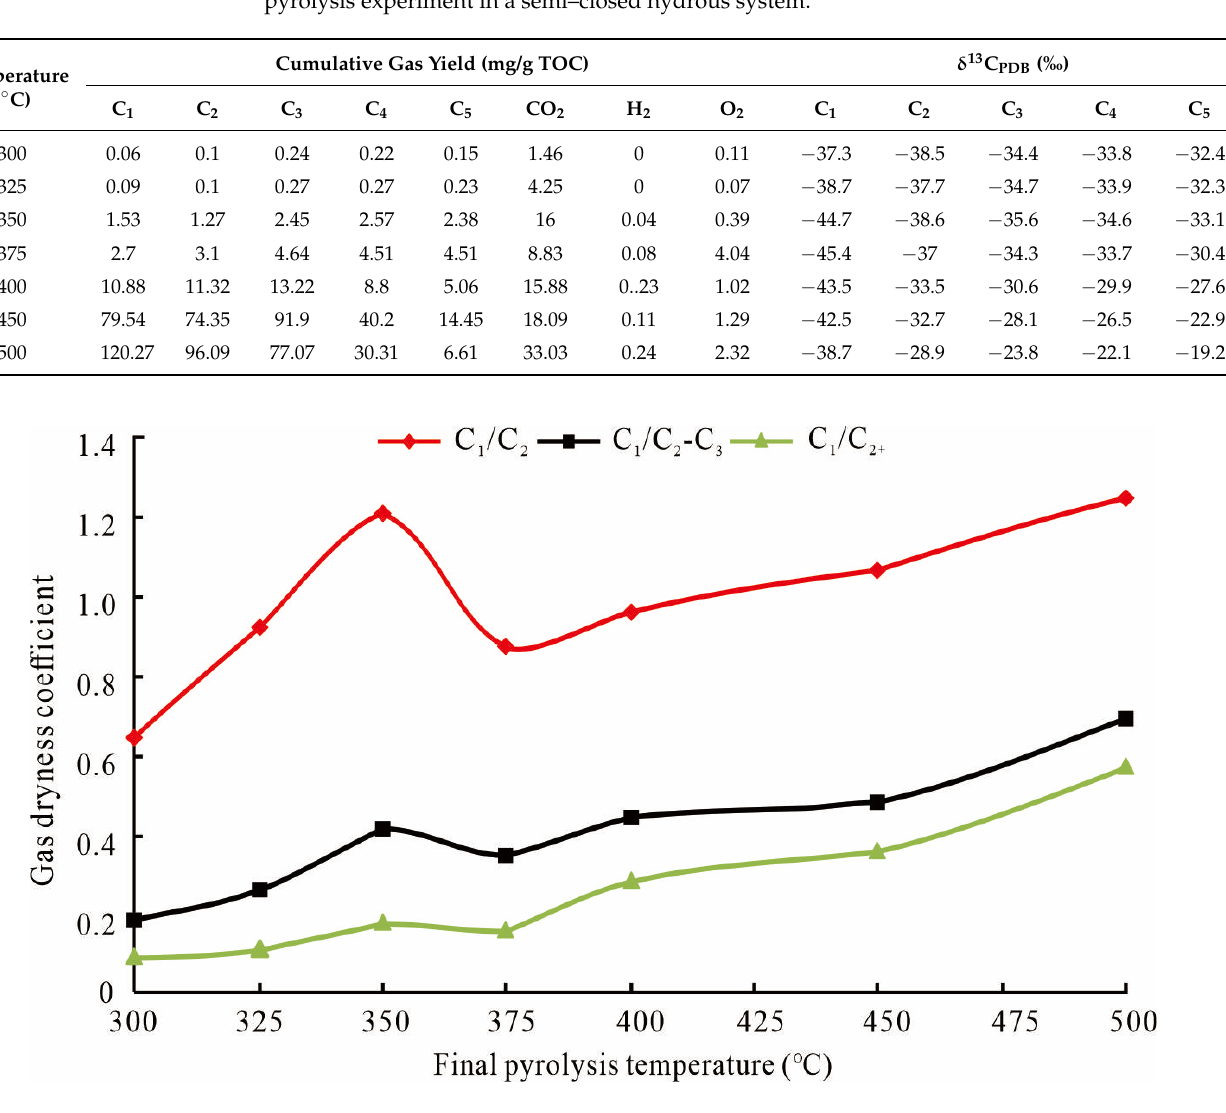
− 19.2 The carbon isotope composition of natural gas is an important parameter for studying the geochemical characteristics of natural gas. Table 4 and Figure 9 show that the distribu- tion ranges of δ 13 C 1 , δ 13 C 2 , δ 13 C 3 , δ 13 C 4 , and δ 13 C 5 were − 45.4% to − 37.3%, − 38.6‰ to − 28.9‰, − 35.5‰ to − 23.8 ‰, − 34.55‰ to − 22.1‰, and − 33.1‰ to − 19.15‰, respectively. The isotope value of methane was higher than that of ethane below 320 °C, but the isotope composition of hydrocarbon gases at other temperatures obeyed the normal carbon isotope sequence, i.e., δ 13 C 1 < δ 13 C 2 < δ 13 C 3 < δ 13 C 4 < δ 13 C 5 . With the increase in the temperature, the carbon iso- tope of hydrocarbon gases first decreased and then increased; in particular, the trend of me- thane change was the most significant. The non–monotonic change in the δ 13 C 1 value may indicate that there were multiple sources of early CH 4 [32,33].